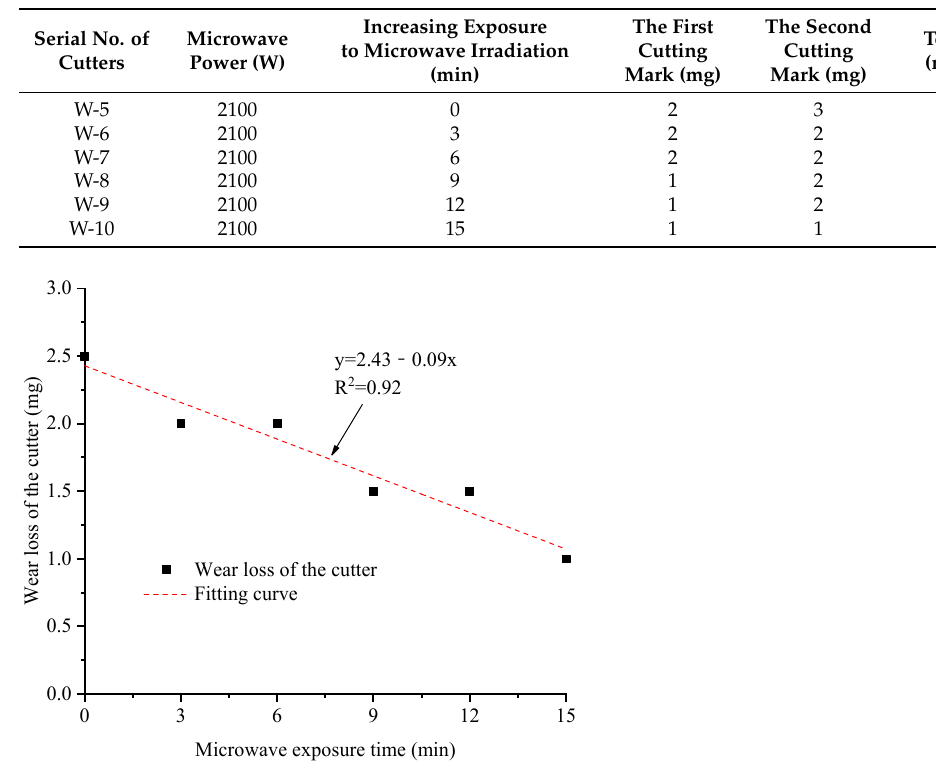
Table 2. Cu tt ing e ff ects of the reduced-scale TBM cu tt er on the samples subjected to di ff erent dura- tions of microwave irradiation.